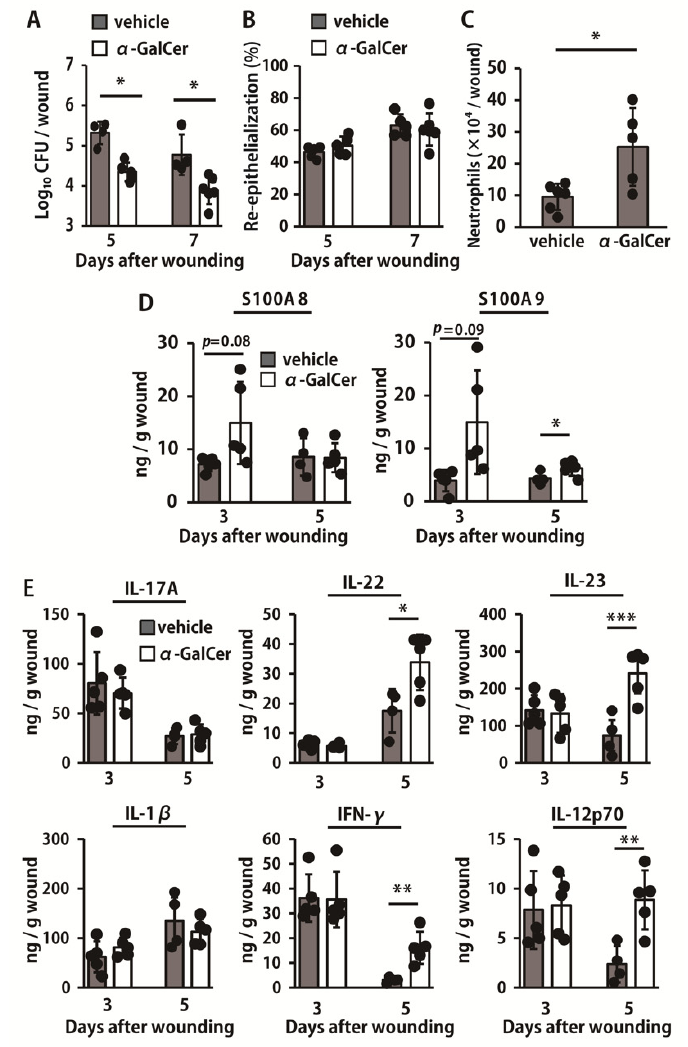
Figure 5. Effect of iNKT cell activation on the bacterial loads, re-epithelialization, neutrophil accu- mulation, and production of antimicrobial peptides and cytokines after infection with P. aeruginosa. Wounds were created on the backs of vehicle- or α -GalCer-treated mice and P. aeruginosa strain PAO1 (0.7–1 × 10 4 CFUs/wound) was directly inoculated at the wound sites immediately after wounding. ( A ) The number of live colonies in the wound on days 5 and 7 postinoculation were counted (n = 4–5). ( B ) Time-course changes in the re-epithelialization ratio after wound creation (n = 5). ( C ) The number of neutrophils, defined as CD45 + Ly6G + CD11b + cells, was analyzed on day 3 (n = 5–6). ( D ) Production of S100A8 and S100A9 in the wound tissue homogenates were measured at each specified point (n = 4–5). ( E ) IL-17A, IL-22, IL-23, IL-1 β , IFN- γ , and IL-12p70 levels in the wounded tissues were measured on days 3 and 5 (n = 4–5). Black circles represent one individual mouse. Each column represents the mean ± SD. The results are representative of at least two independent experiments. * p < 0.05, ** p < 0.01, *** p < 0.005.